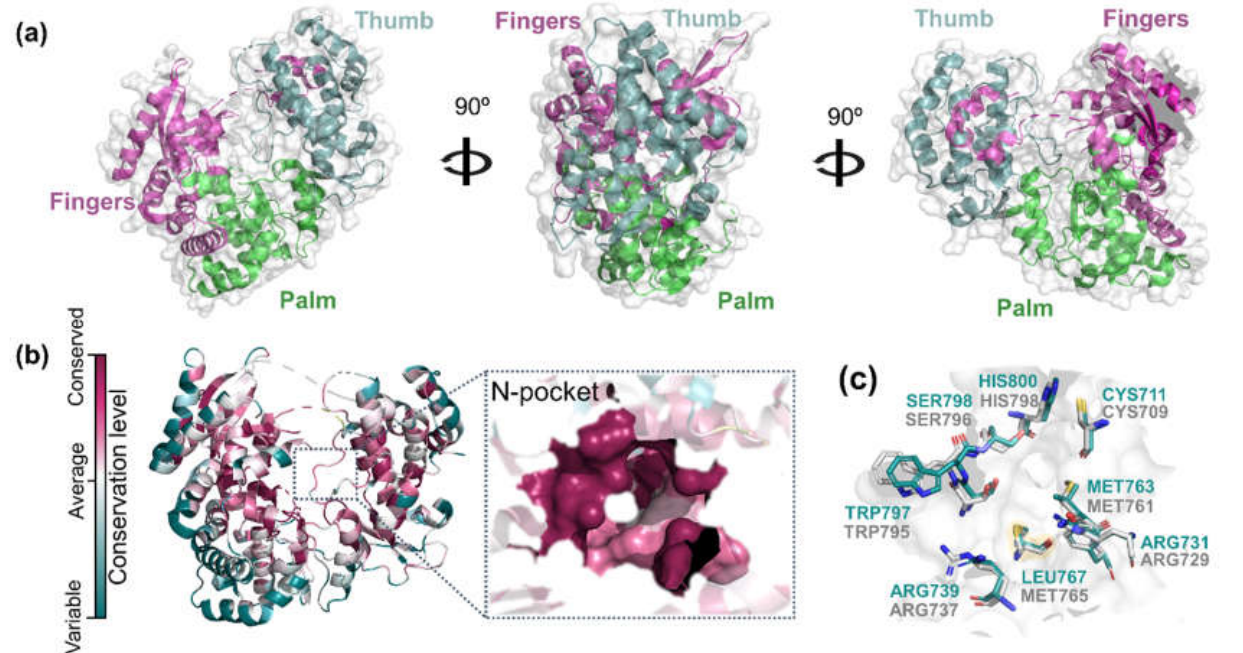
Figure 2. Structural analysis of RdRp proteins from ZIKV (PDB ID: 6LD4) and DENV (PDB ID: 5I3Q). ( a ) Cartoon backbone diagram showing the front, side and back views of ZIKV RdRp. The fingers, thumb and palm domains are colored in magenta, cyan and green, respectively. ( b ) ConSurf analysis of ZIKV RdRp and corresponding N -pocket site. The magenta color indicates high conservation while white and turquoise colors indicate average and very low conservation, respectively. ( c ) Structural overlap of ZIKV and DENV N -pocket sites. ZIKV and DENV residues are colored in cyan and gray,